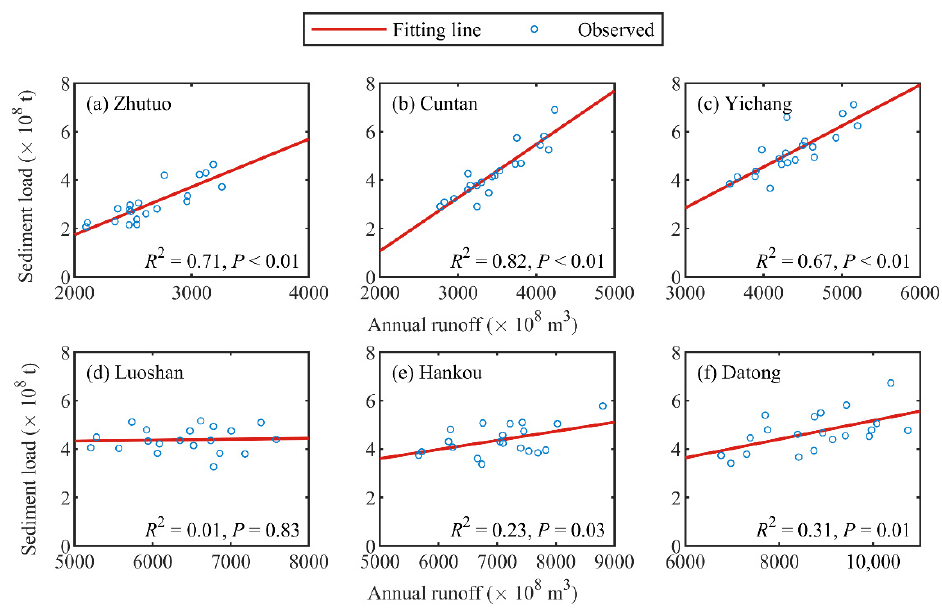
Figure 7. Relationships between a sediment load and annual runoff during the natural period.